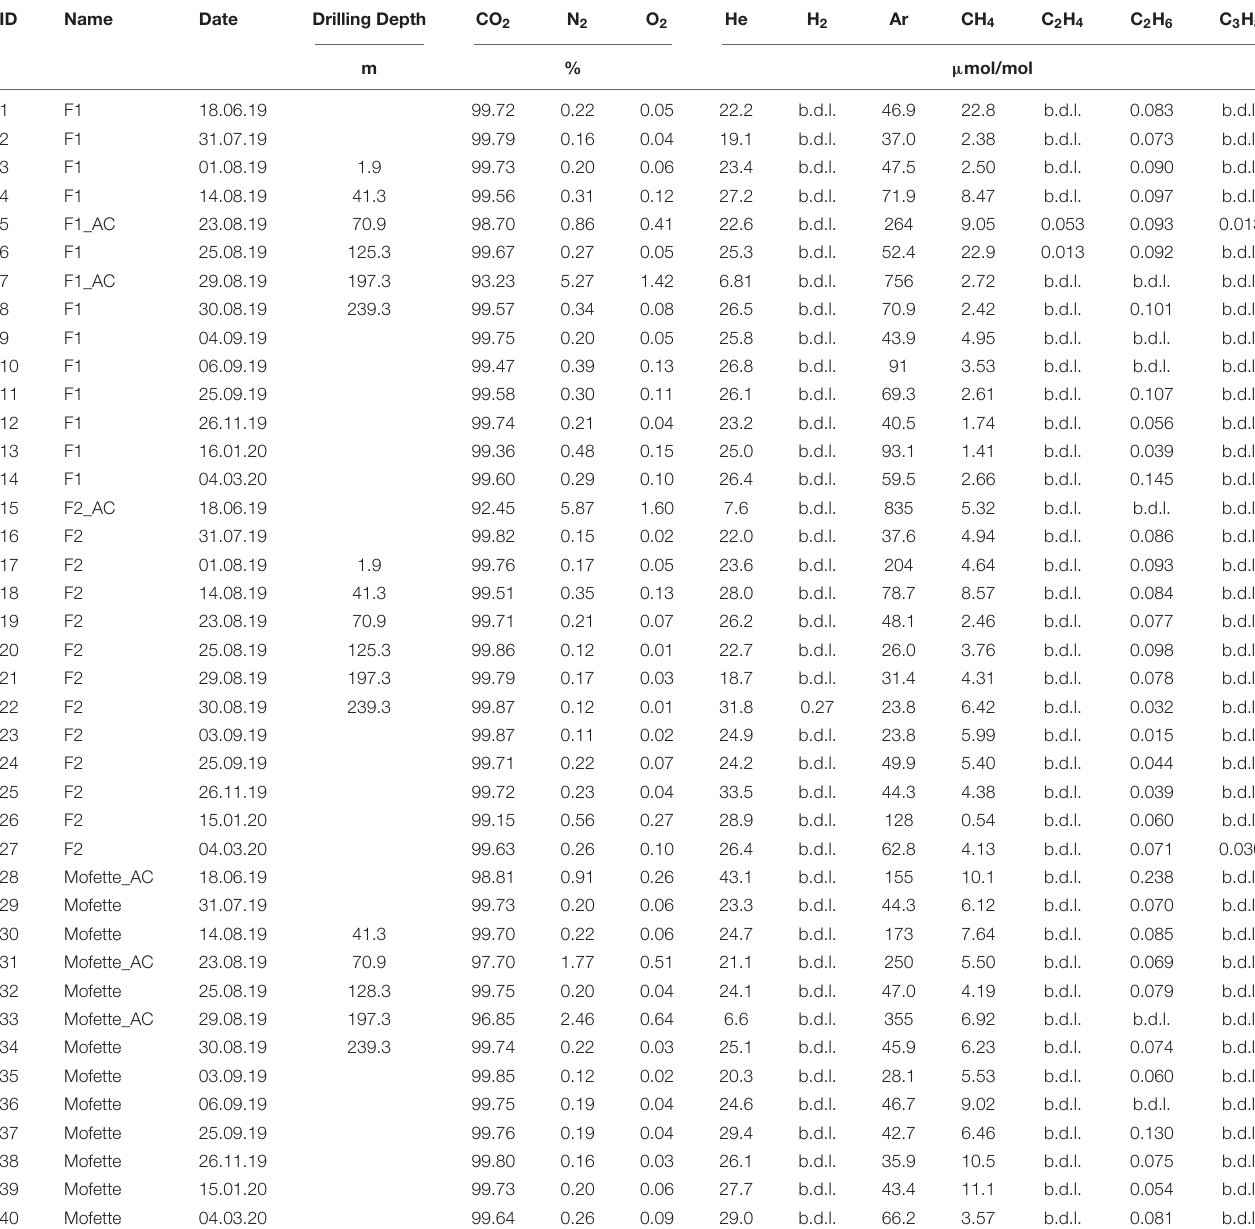
TABLE 1 | Analytical results of collected gas